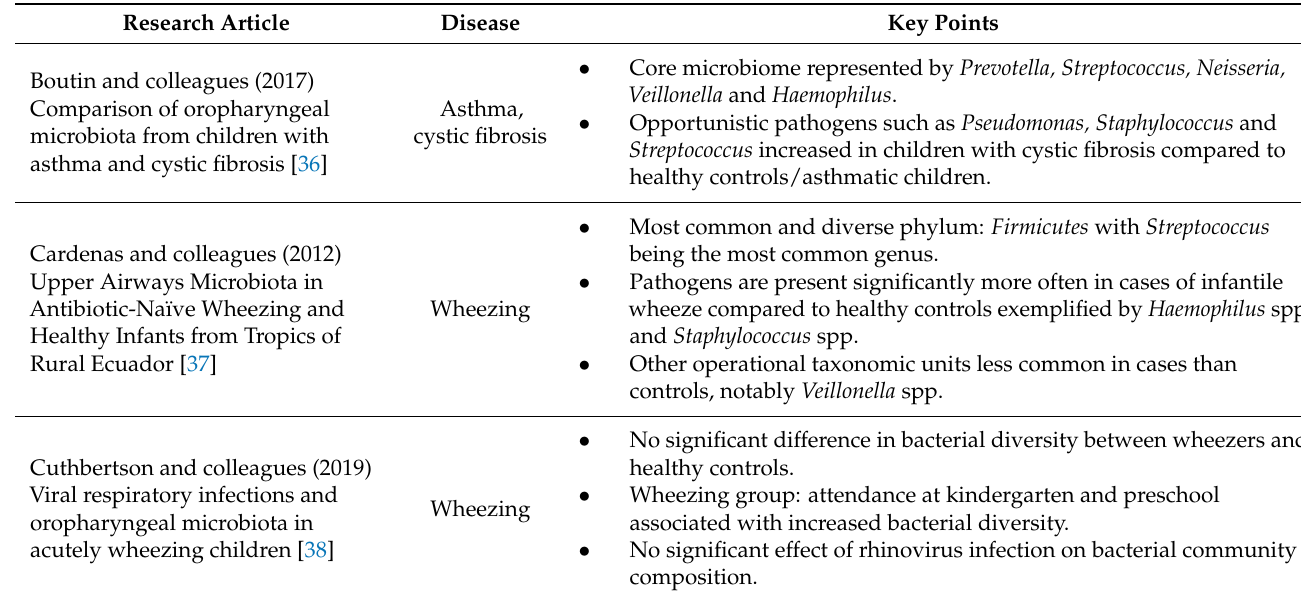
Table 1. Overview of articles focusing on the oropharyngeal microbiota of the upper respiratory tract of children suffering from asthma, wheezing, and exacerbation or respiratory infections from 2012 to